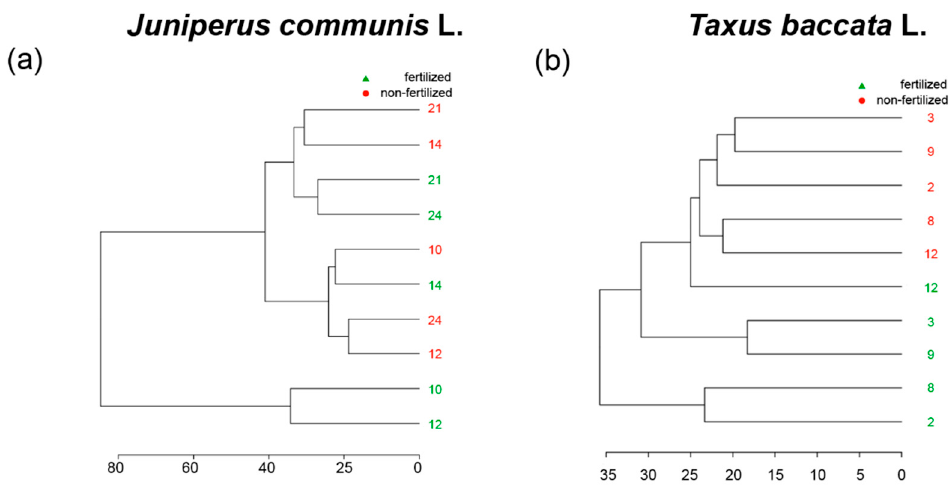
Figure 4. Dendrogram of the metabolome of ( a ) Juniperus communis L. and ( b ) Taxus baccata L. pollen grains collected from fertilized and non-fertilized male plants, generated with measured Euclidean distances and ward.D algorithm. Numbers in green indicate number of genotypes grown in fertilized conditions, whereas numbers in red indicate number of genotypes grown in non-fertilized conditions.